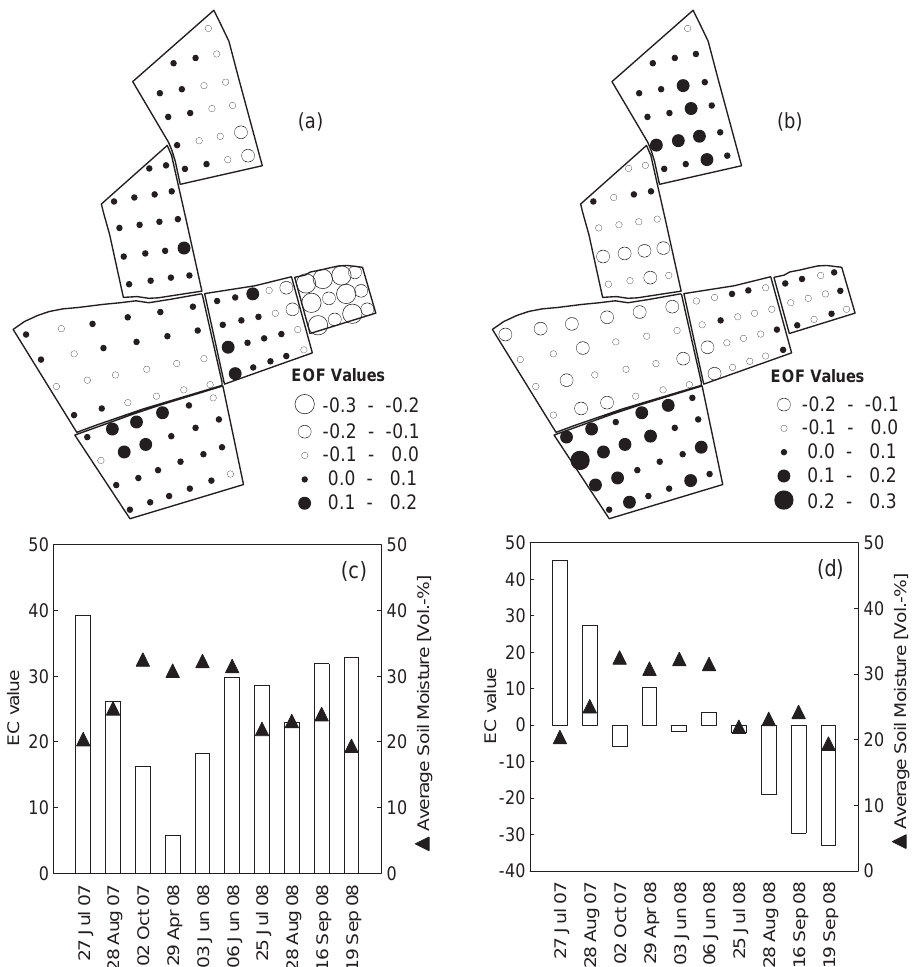
33Figure 7. EOF1 (a), EOF2 (b), EC1 (c) and EC2 (d) patterns of the spatial analysis in the Fig. 7. EOF1 (a) , EOF2 (b) , EC1 (c) and EC2 (d) patterns of the spatial analysis in the arable test site; the triangles in (c) and (d) represent arable test site; the triangles in (c) and (d) represent the average soil moisture on the the average soil moisture on the different different days.